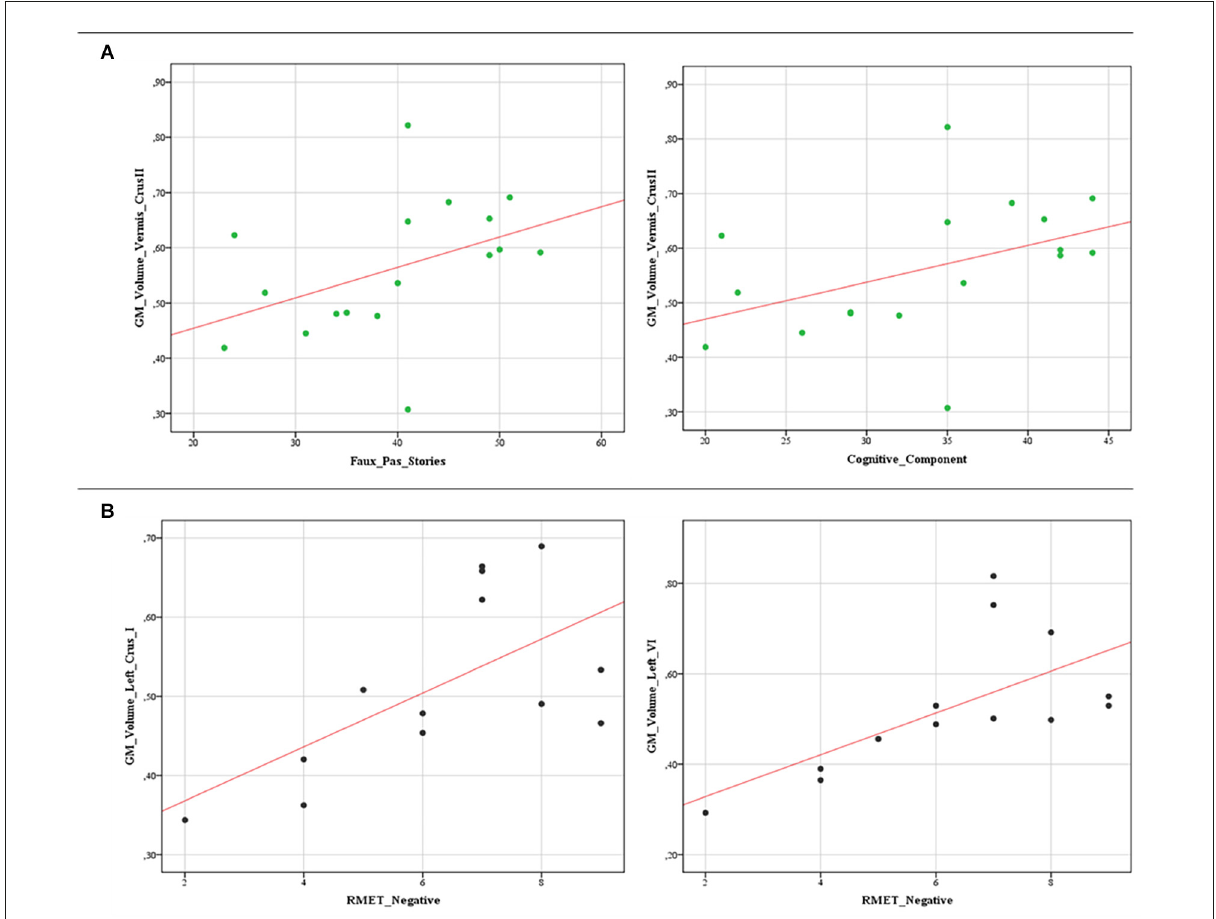
FIGURE3 Data scatterplots. Significant correlations between decreased cerebellar GM volumes and the poor ToM scores in BD1 (A) and BD2 (B) patients are reported. (A) Positive correlations between the total score ( r = 0.540; p = 0.025) and the cognitive component score ( r = 0.511; p = 0.036) on the Faux Pas stories and GM volumes in the Vermis Crus II. (B) Positive correlations between the scores at the negative stimuli of the RMET and the reduced cerebellar GM volumes in the left crus I ( r = 0.625; p = 0.022) and in the left lobule VI ( r = 0.756; p =